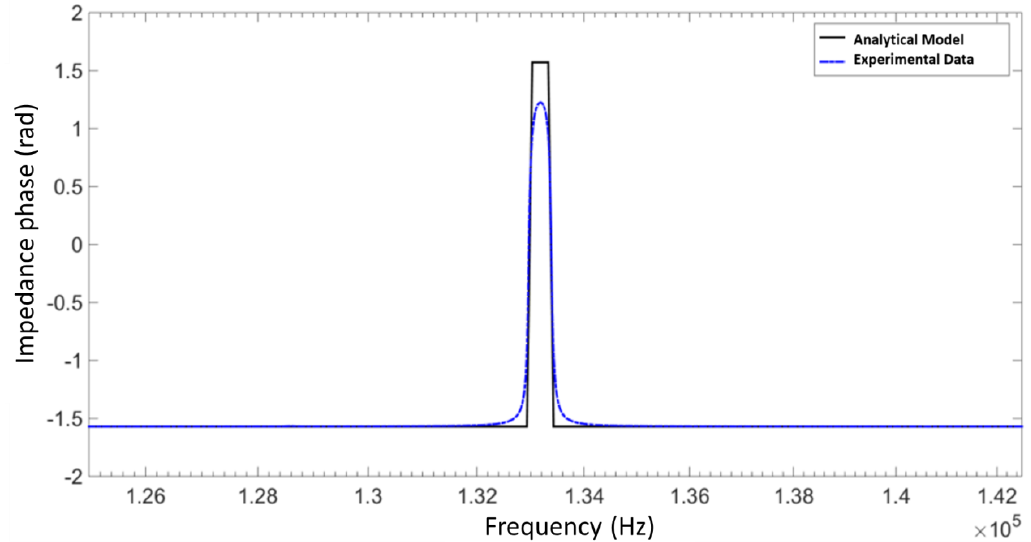
Figure 3. Electrical impedance phase spectrum in monocrystalline paratellurite about the fundamental face-shear piezoelectric excitation.